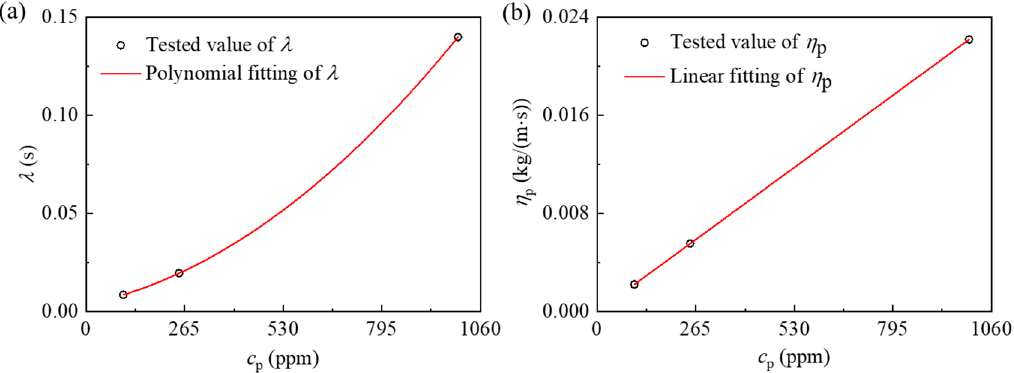
Figure 3. ( a ) Polymer dynamic viscosity η p and ( b ) relaxation time λ as a function of the polyacrylamide (PAA) concentration, c p .